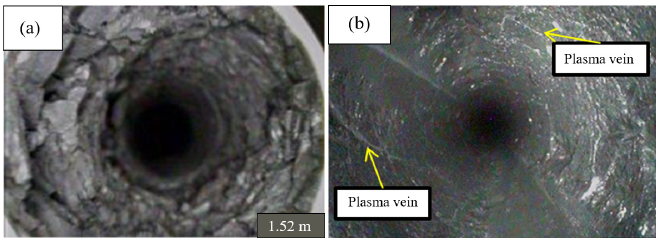
Figure 23. Comparison of drilling views before and after grouting ： ( a ) before grouting; ( b ) after grouting.